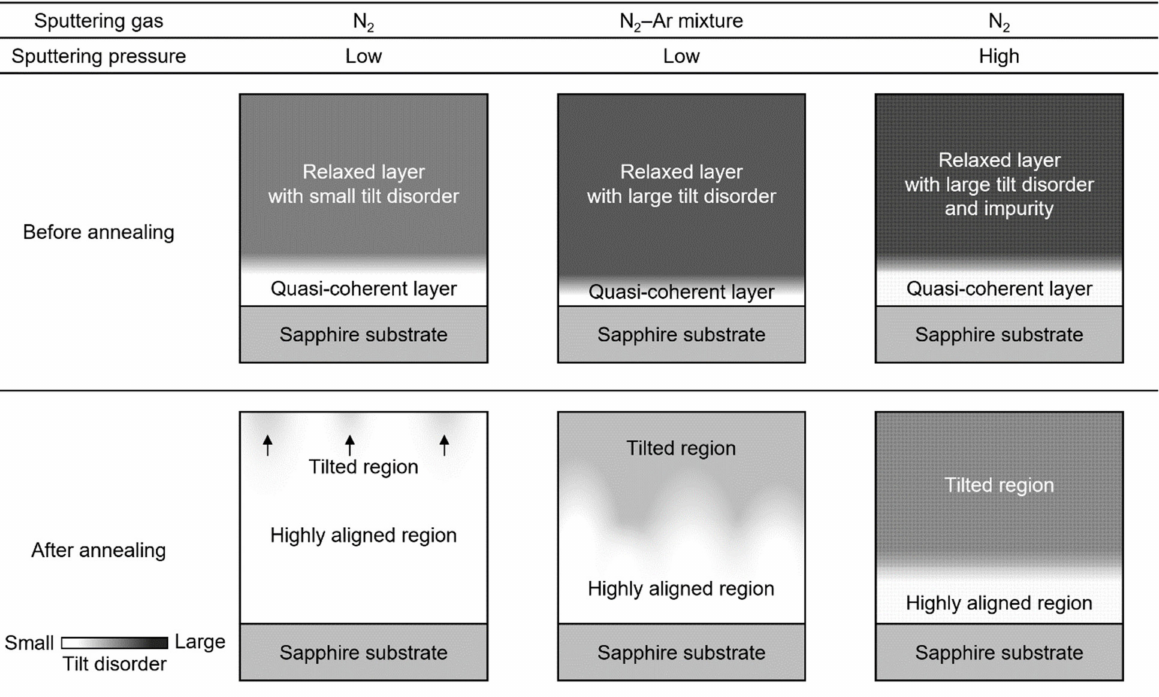
Figure 9. Schematic diagram of the tilt disorder distribution in AlN films, before and after annealing, sputtered under three typical